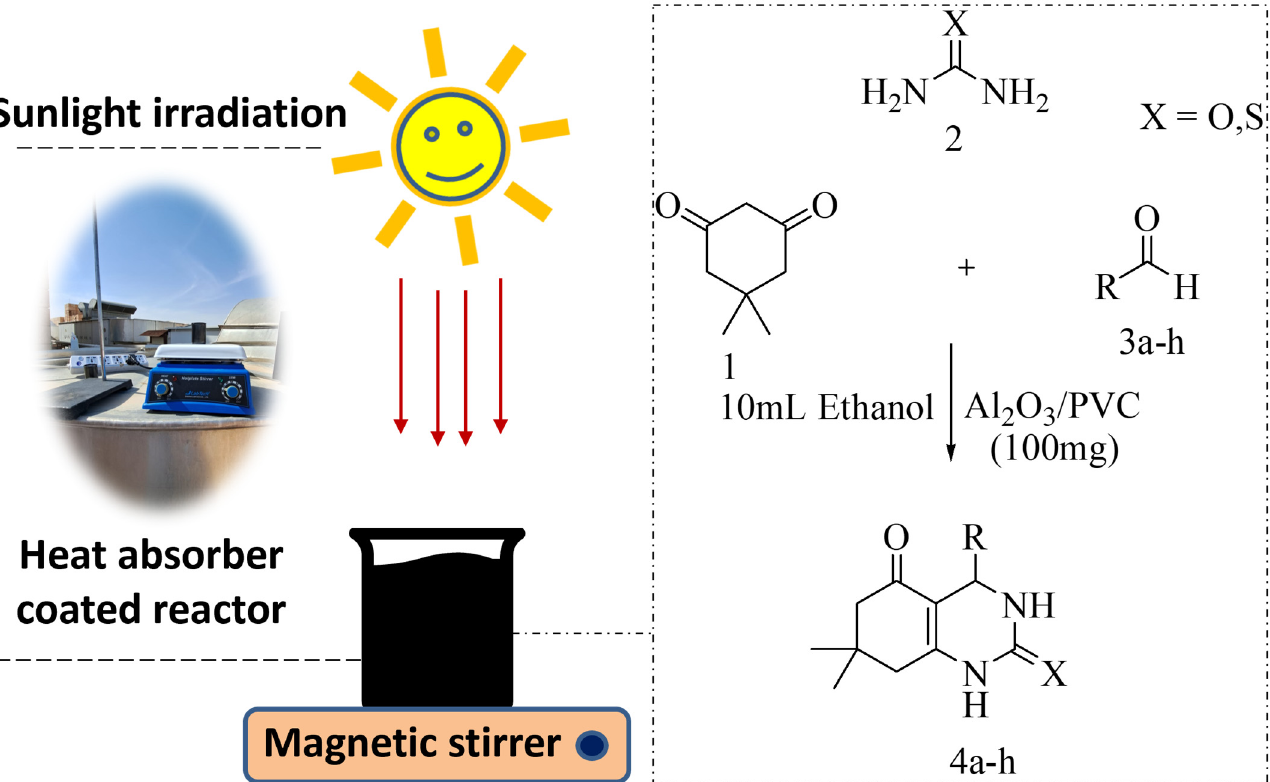
Figure 1. The setup used in the present study for the thermocatalytic synthesis of octahydroquinazo- linone by Al 2 O 3 /PVC catalyst.